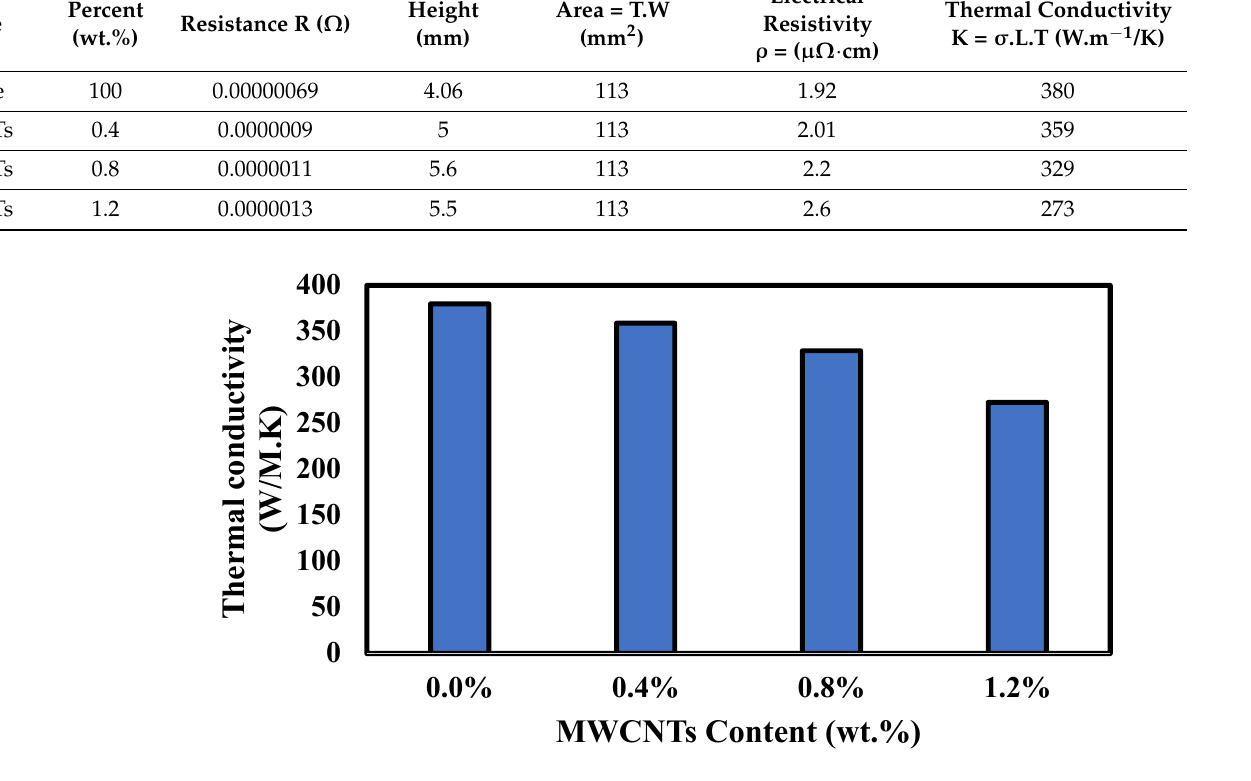
Figure 7. Thermal conductivity of MWCNT content on Cu nanocomposites.